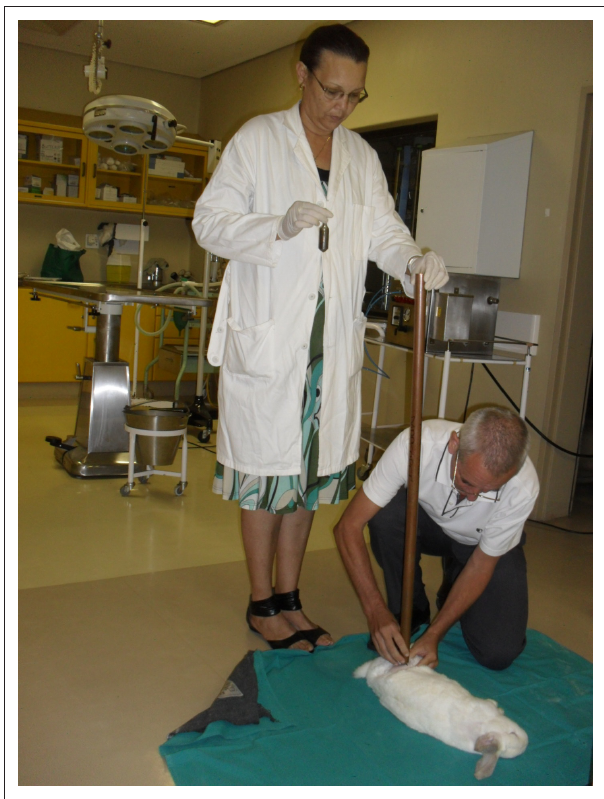
FIGURE 1: A 100 cm guide tube held vertically and carefully centred over the marked vastus lateralis muscle.